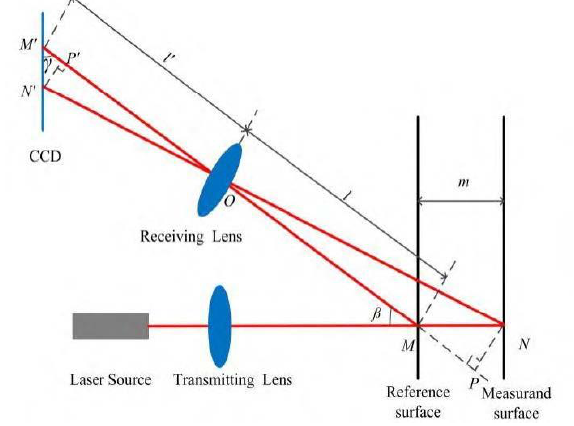
Fig. 1. Rationale of laser triangulation method